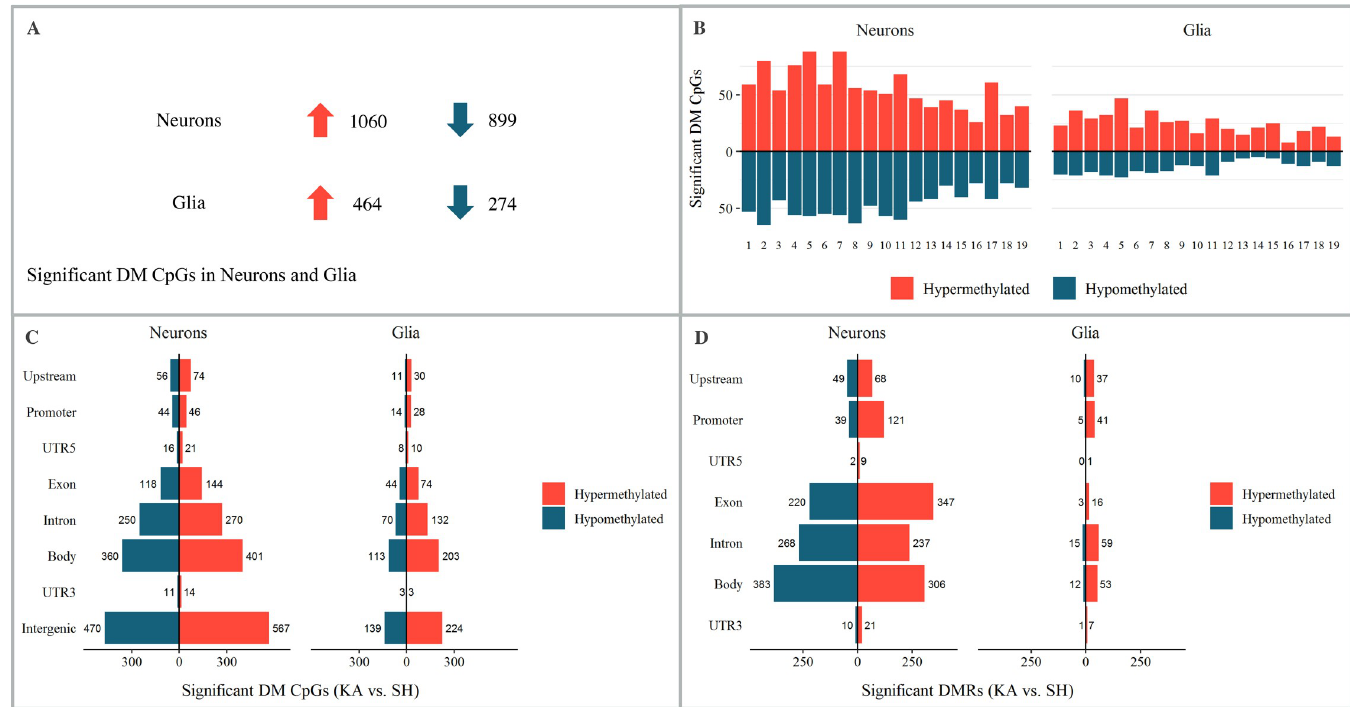
Fig 1. Differential DNA methylation at 24 hours post injection in the intracortical kainic acid model of mTLE. (A)–(C) Statistical analysis of differentially methylated CpGs (DM CpGs) of KA versus SH group, 24 hours post injection. (A) DM CpGs in neurons and glia; upward arrow indicates hypermethylation and downward arrow hypomethylation of DM CpGs. (B) Chromosomal distribution of DM CpGs. (C) Distribution of DM CpGs amongst genomic features. (D) Distribution of differentially methylated regions (DMR) amongst genomic features.